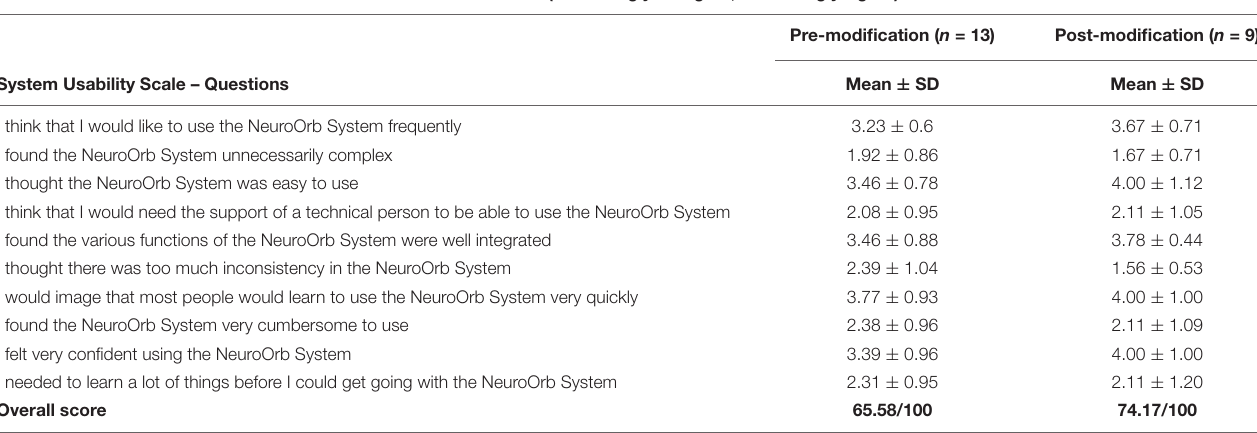
TABLE 5 | Results of the system usability scale questionnaire: pre- versus post-modifications. Scores are based on a scale of 1–5 (1 = Strongly Disagree, 5 = Strongly Agree). Mean ±